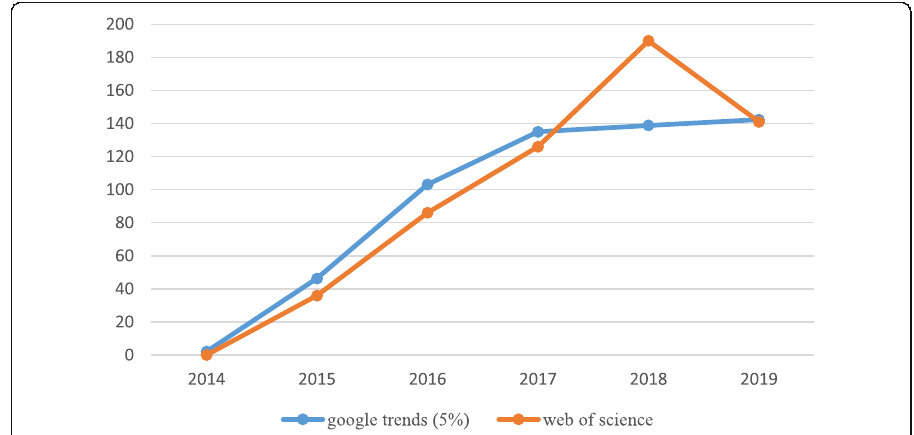
Fig. 1 Google trends search volume and number of academic papers on web of